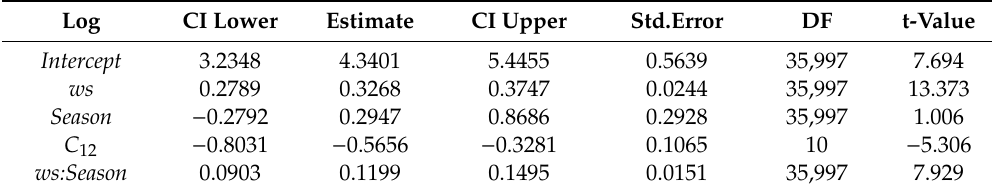
Table 5. Season model results.